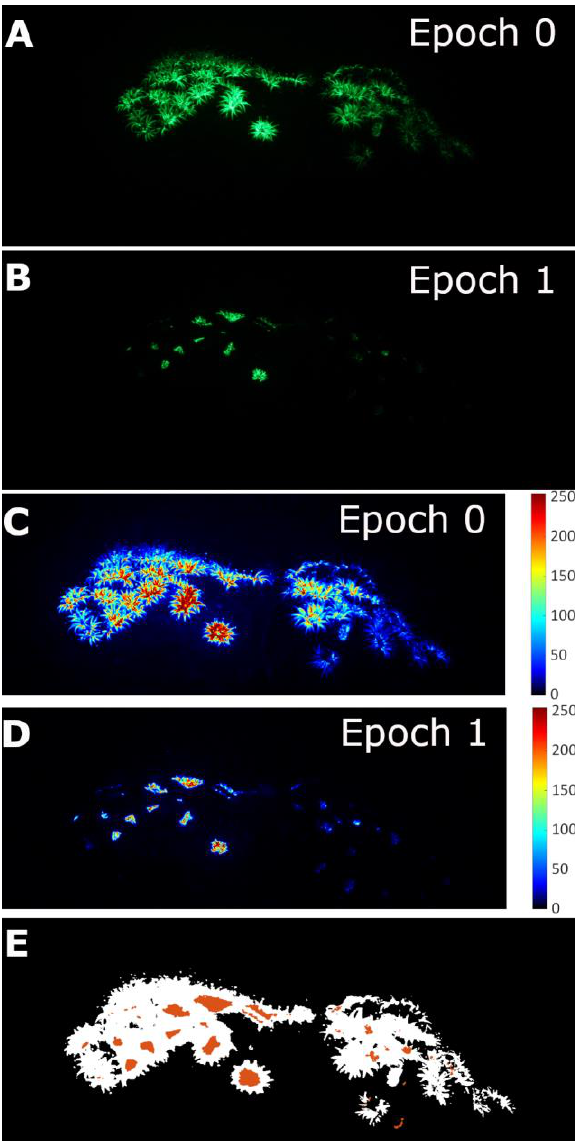
Figure 3 . A- Views of photogrammetric 3D model. The colony was 6-7 cm in length. B-Portion used for the co-registration of subsequent epochs, deviation analysis. C- Results of multitemporal comparison, calculated distances, and statistics; black circle points out the impact of the anchor.